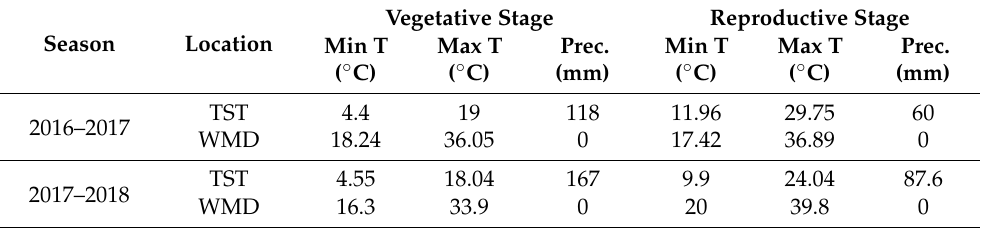
Table 3. Average minimum and maximum temperatures ( ◦ C) and precipitations (mm) at vegetative and reproductive stages during two cropping seasons (2016–2017 and 2017–2018) at Tessaout (TST) and wad Medani (WMD).